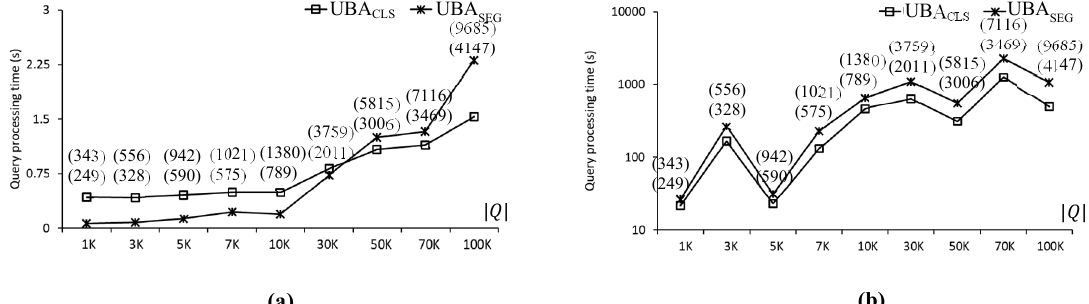
Figure 10. Effect of two-step clustering on the CAL roadmap: ( a ) uniform data points. ( b ) Skewed data